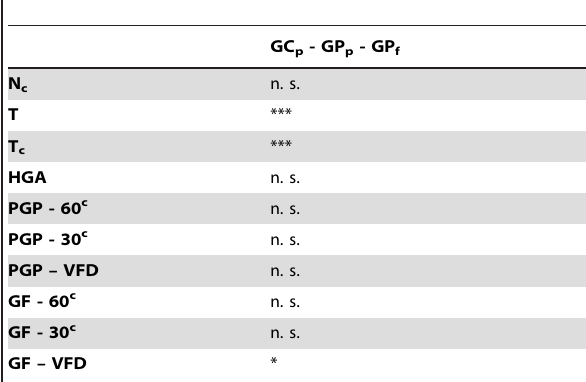
Table 1. Performance and gaze-related parameters for glaucoma control subjects who passed (GCp), glaucoma patients who passed (GPp), and glaucoma patients who failed the task